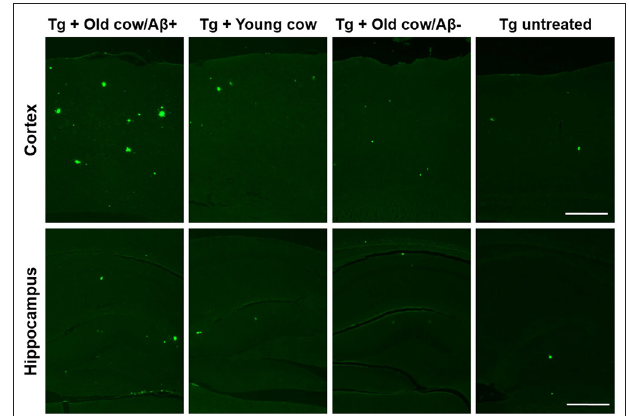
FIGURE 4 | A β − rich cattle tissue induced high amounts of fibrillar plaques. Representative pictures of ThS staining in APP/PS1 transgenic mice inoculated with brain extracts from A β − containing old cattle, old cow with no detectable A β aggregates, and young cattle. For a negative control, we used transgenic mice left untreated. Scale bar: 250 µ